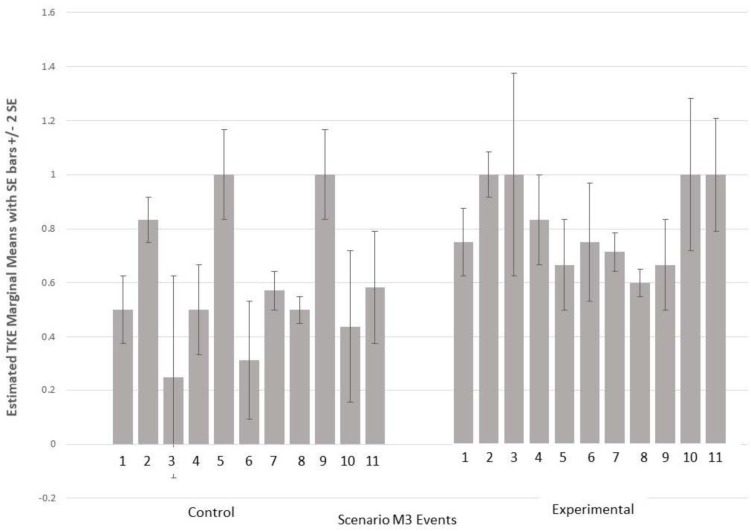
Estimated TKE marginal means and standard error for M3 scenario events.